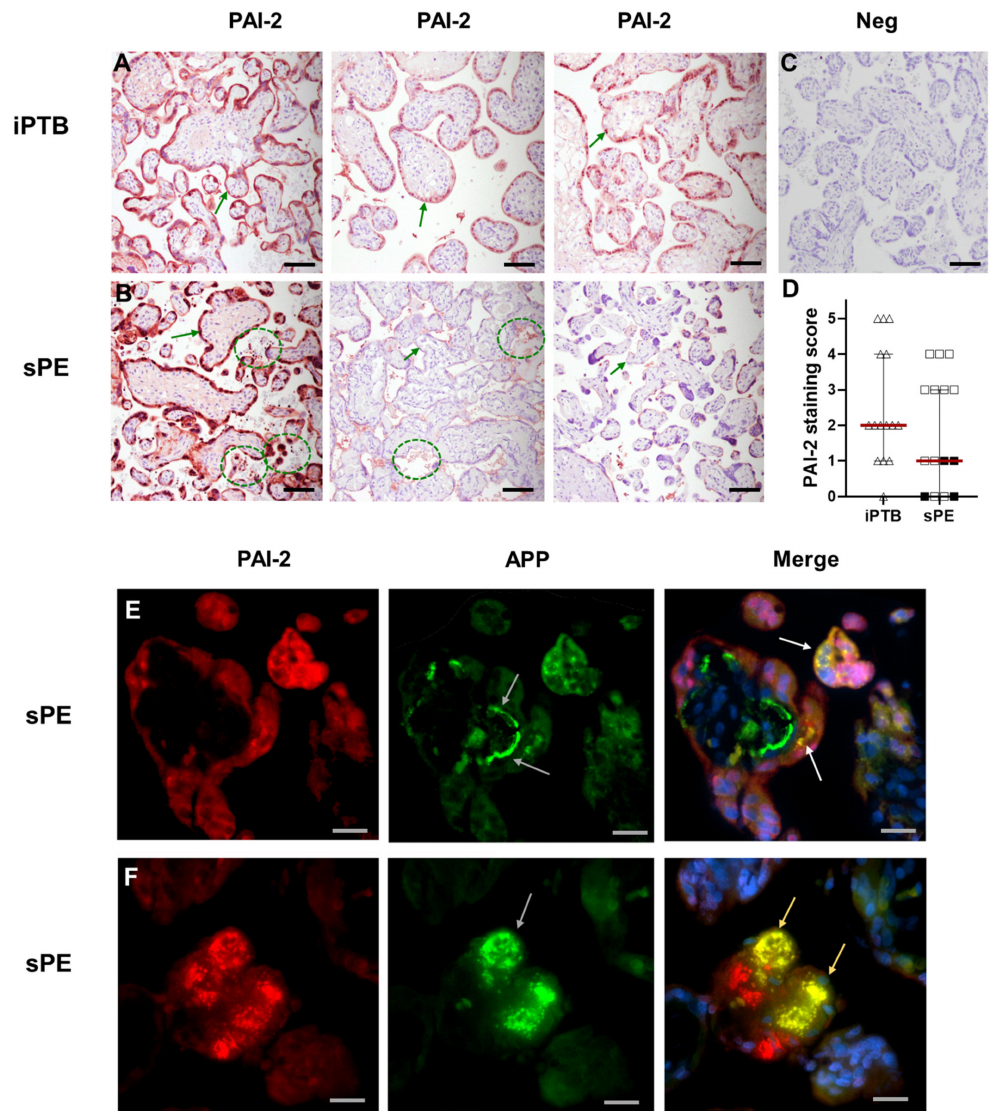
Figure 4. Immunolocalisation of PAI-2 and APP in placenta. Representative immunostaining for PAI-2 in placenta of women who delivered in the context of idiopathic preterm birth (iPTB, ( A )) or severe early-onset preeclampsia (sPE, ( B )). Green arrows mark the syncytiotrophoblast. Each micrograph is from a different case to illustrate the interpersonal variation in staining pattern in both groups. The marquee-circled areas (( B ), left and middle images) show PAI-2 positive debris abundant in maternal vascular spaces observed frequently in sPE cases. Also in panel ( B ) ( right image) is the placenta from women with sPE and HELLP syndrome, which shows only weak staining (score 1). The negative image (( C ); Neg) is from a slide incubated with non-immune IgG instead of primary antibody. ( A – C ), original magnification 200 × (scale bar: 50 µ m). ( D ) Scatterplot of PAI-2 staining score for iPTB ( n = 15) and sPE ( n = 15). sPE women with HELLP manifestations ( n = 4) are shown as filled black squares. ( E , F ), Double immunofluorescence for PAI-2 (red) and APP (green) on a representative sPE placenta, which shows that some but not all PAI-2 staining co-localises with APP. The white arrows in ( E ) (merge image) point to intracellular co-localisation of PAI-2 and APP in syncytiotrophoblast. Note the irregular shape of extracellular APP staining shown by grey arrows (( E , F ), APP images), consistent with aggregated A β , which is free of PAI-2 staining in ( E ) (merge image), but partially co-stains with PAI-2 as marked by yellow arrows in ( F ) (merge image). The blue counterstain marks the nuclei. ( E , F ) original magnification 400 × (scale bar: 25 µ